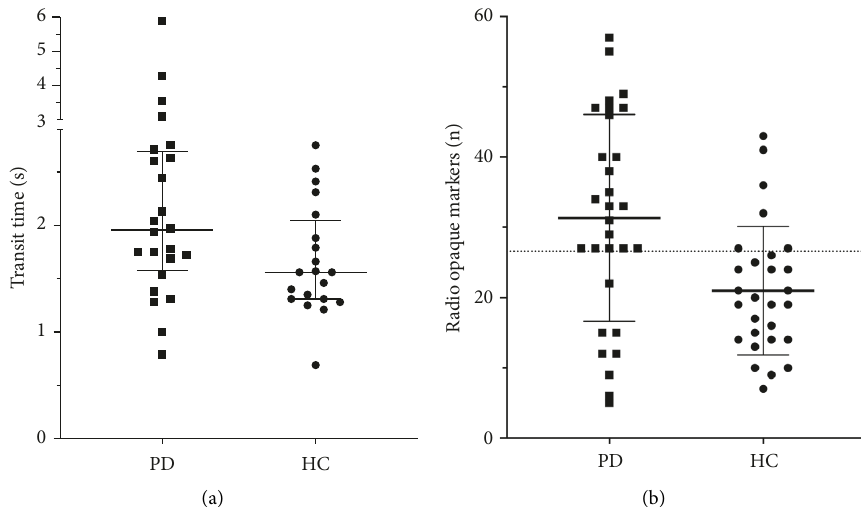
Figure 2: (a) Transit time through the distal four centimeters of the esophagus ( p < 0 . 017). Bars indicate median with interquartile range. (b) Total number of retained radio-opaque markers (ROM) in the gastrointestinal tract ( p � 0 . 0021). Bars indicate mean ± SD. Dotted line indicates a tentative cutoff for prolonged intestinal